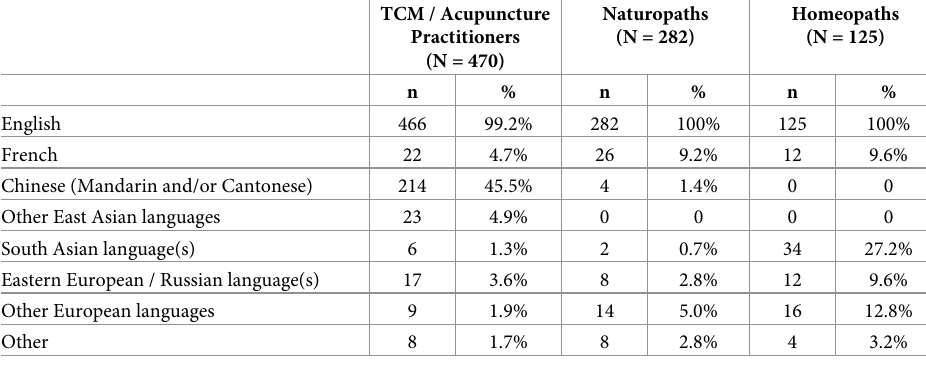
a Total n > N across all groups as some respondents reported using more than one language / language group in clinical practice.